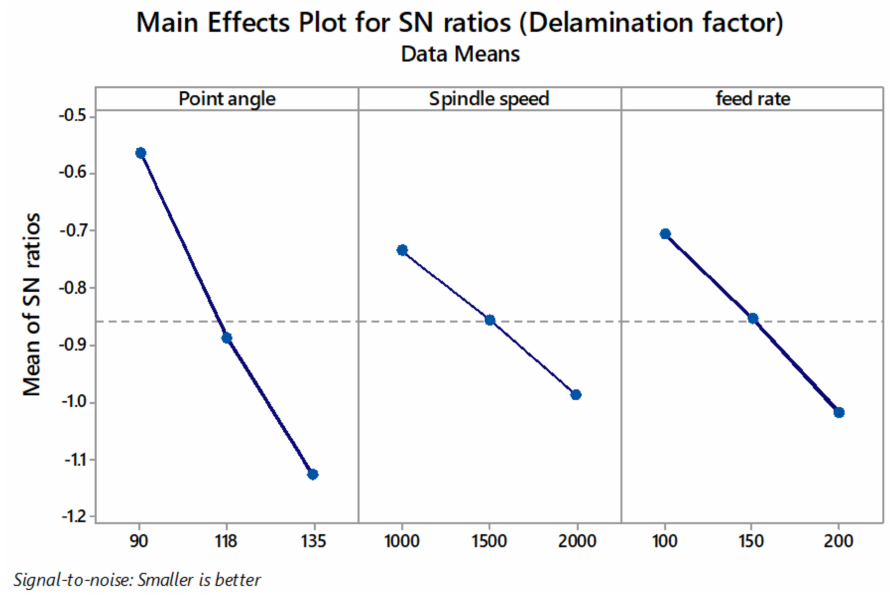
Figure 9. Main effect plot for S/N ratios of delamination